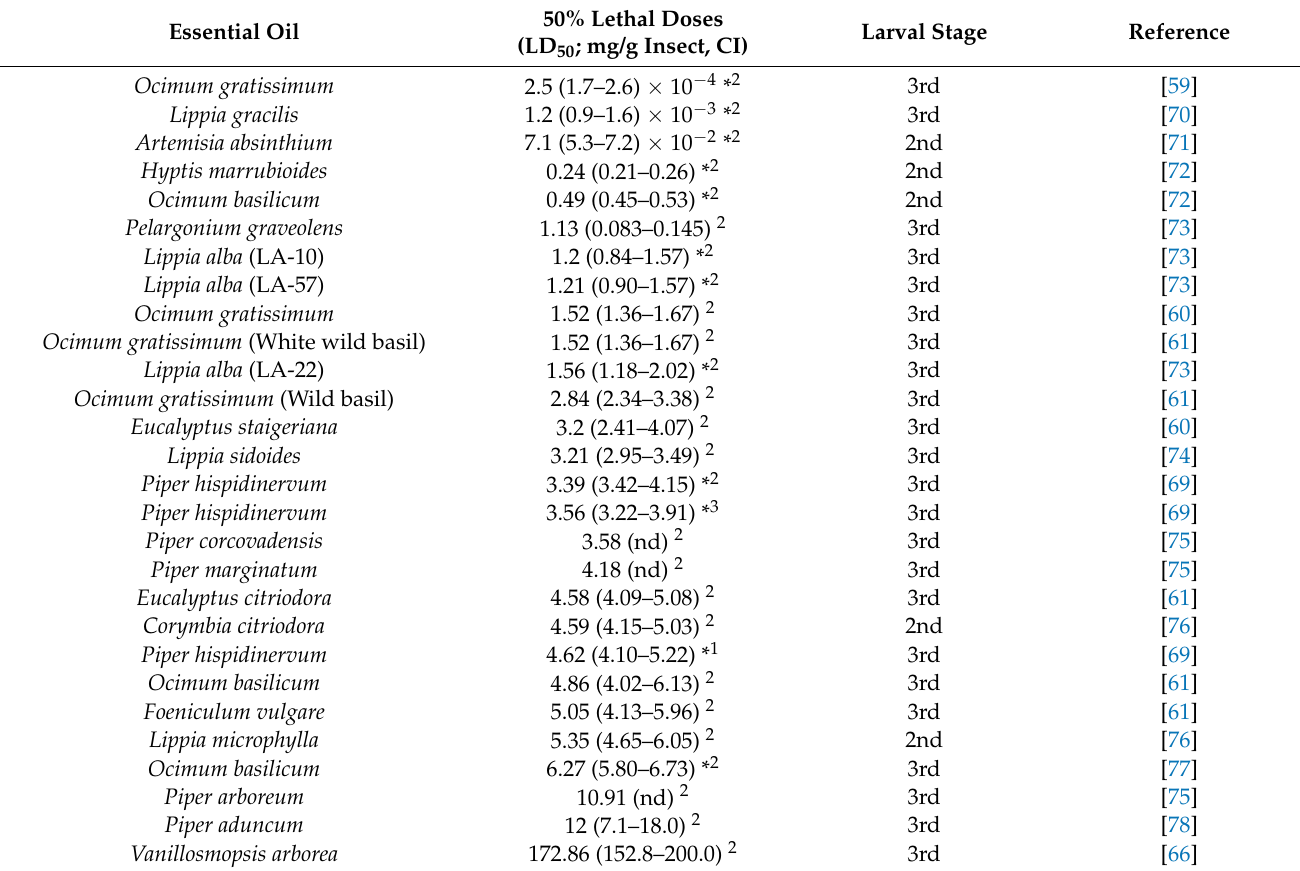
Table 5. Lethal effects of essential oils tested by the topical application method.